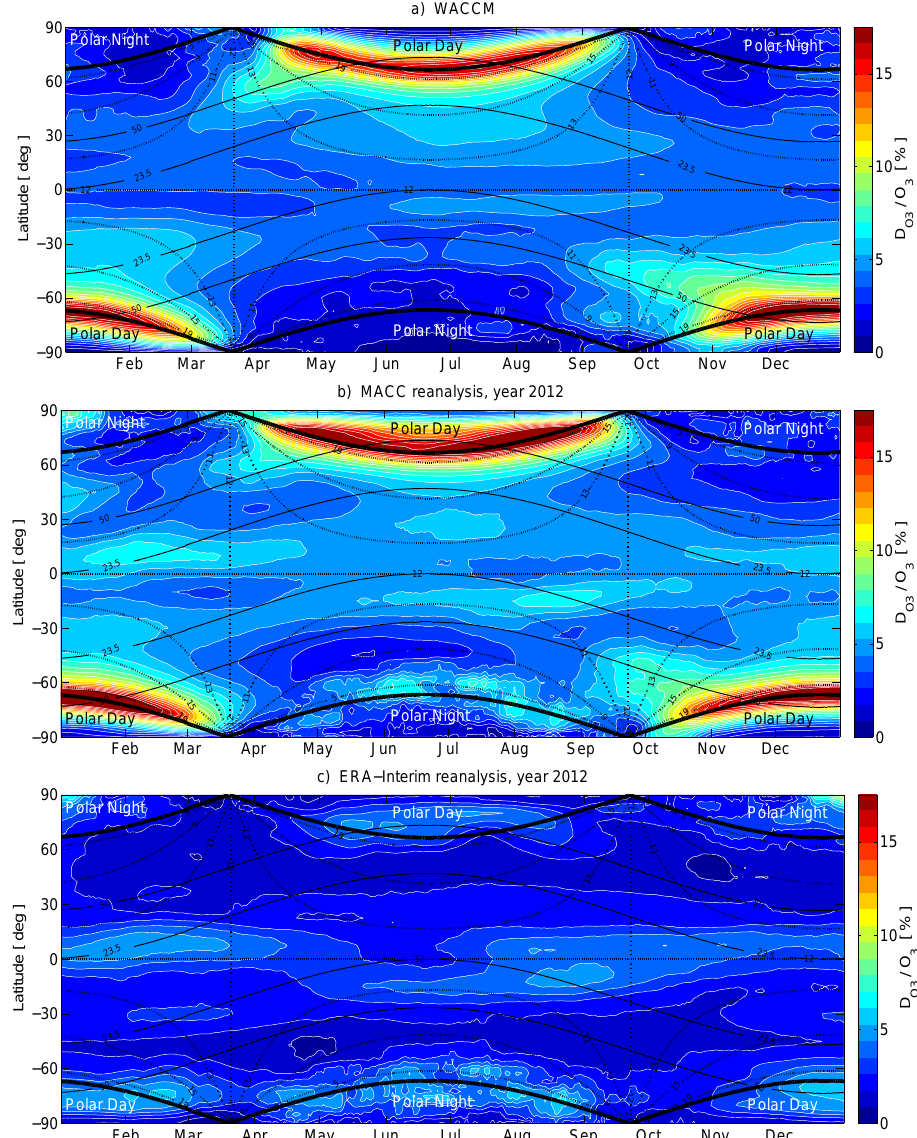
Figure 5. Seasonal behavior of D O /O 3 (see Equation (7)) at 3 hPa derived from ( a ) WACCM, 3 ( b ) MACC reanalysis, and ( c ) ERA-Interim (the latter two from 2012). The presented continuous monthly means are achieved by a sliding time window of ± 15 days. The solid contour lines refer to the solar zenith angle at noon. Dashed contour lines show the sunshine duration given in